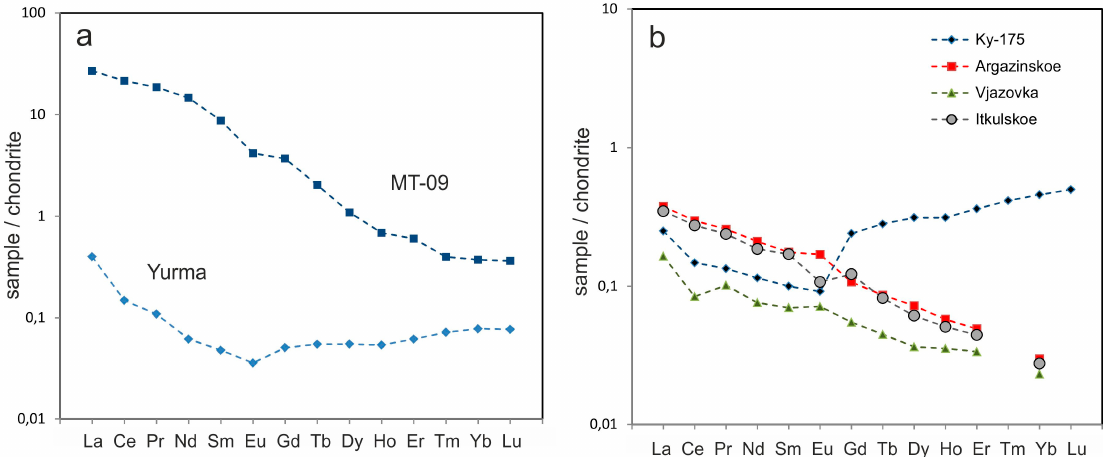
Figure 10. Chondrite-normalized rare earth element (REE) distribution patterns of quartzite ( a ) and hydrothermal vein quartz ( b ) (normalization according to data of Anders and Grevesse [22]. Three of the hydrothermal quartz samples (Argazinskoe, Vjasovska, Itkulskoje) are similar both in absolute REE values and in their chondrite-normalized REE patterns, which correspond to the common crustal distribution (Figure 10b). Only a slight negative Ce anomaly (Vjazovka) and negative (Itkulskoe) or positive (Argazinskoe, Vjazovka) Eu anomalies are detectable. Quartz Ky-175